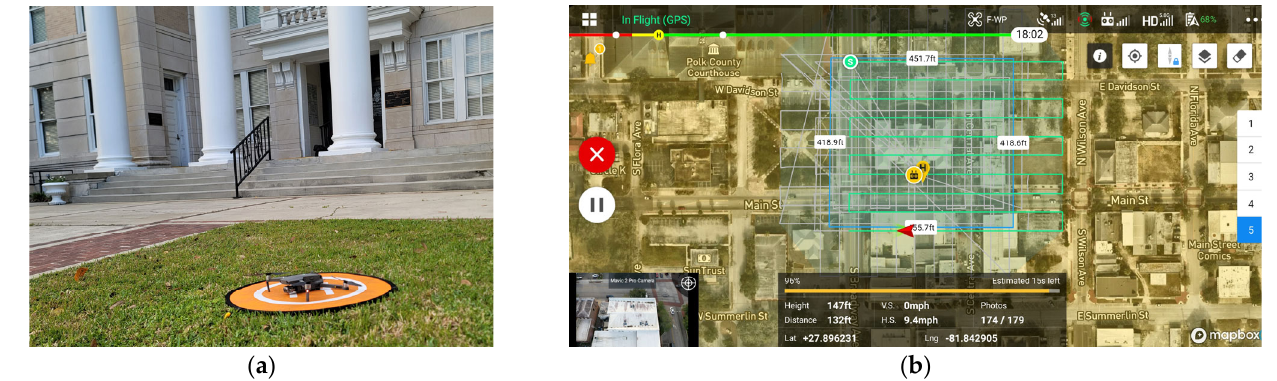
Figure 22. Capturing aerial photos of the OPCC with an UAV: ( a ) a DJI Mavic Pro2 UAV taking off